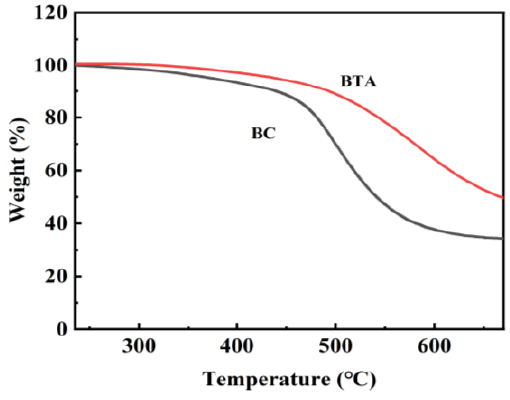
Figure 5. TGA images of BC and BTA.